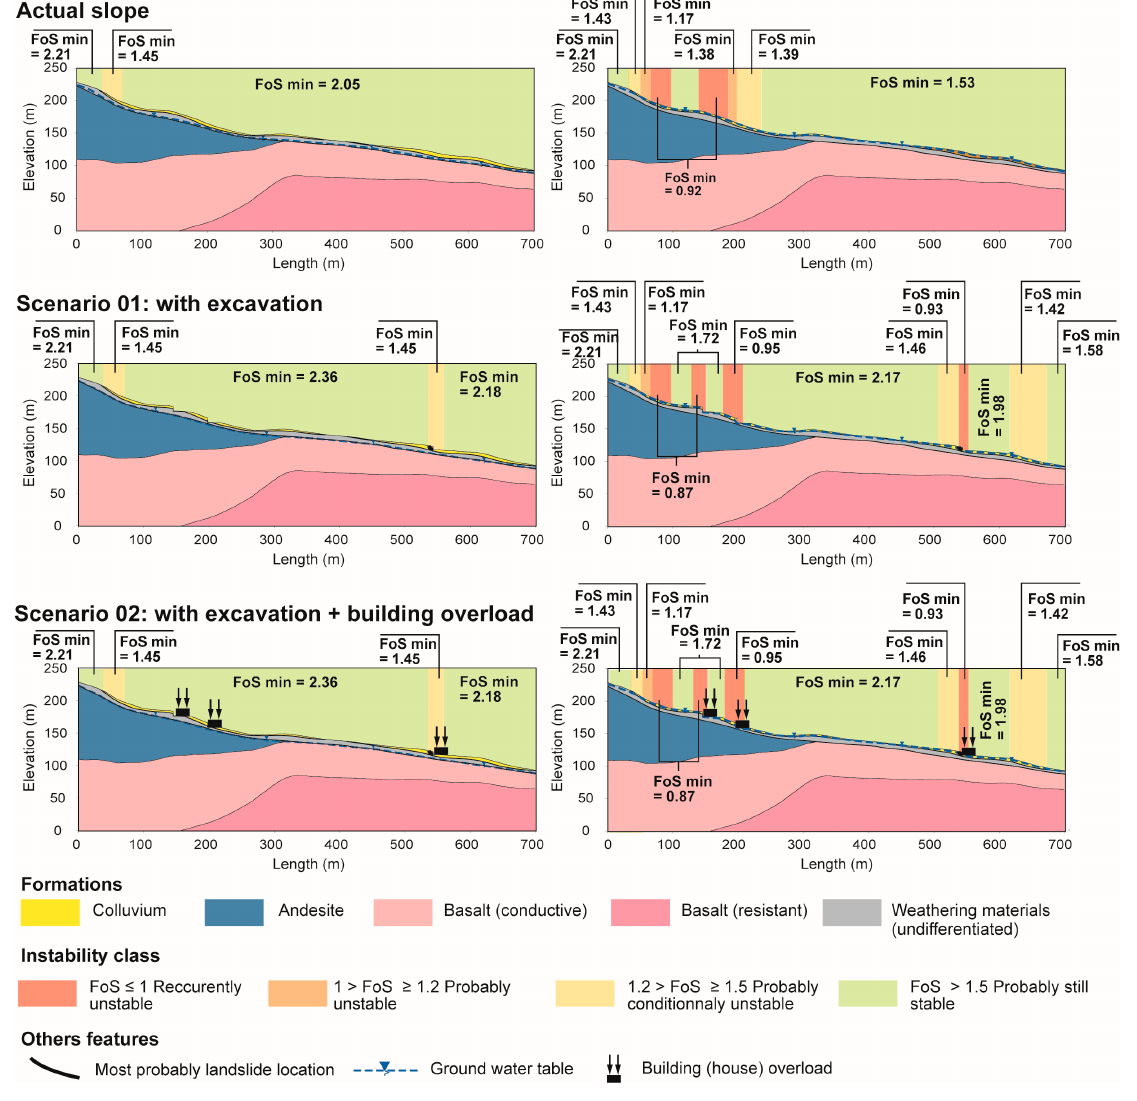
Figure 8. Slope stability analysis for shallow landslides (translational + rotational) on a representative cross section. The location of the cross section is given in Figure 10.